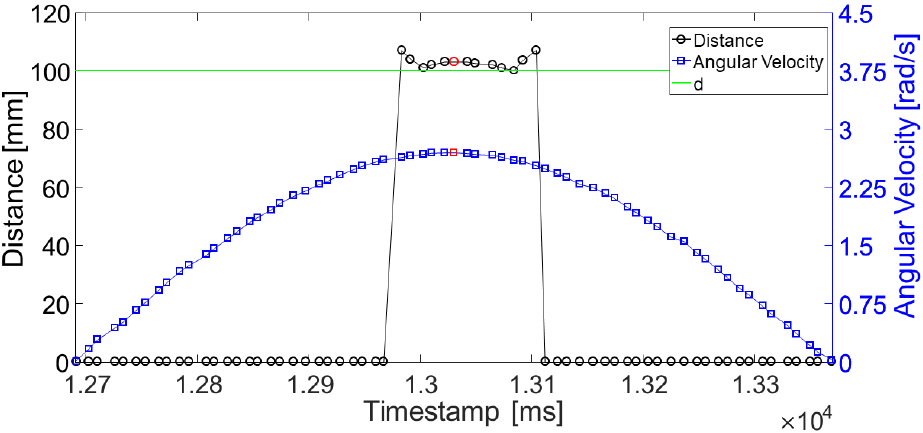
Figure 8. An example of the readings, provided by the Infrared Time-of-Flight proximity sensor (IR-ToF) and re-sampled at 100 Hz, is reported for an oscillation k with an AoI equal to 0 ◦ and d = 100 mm. The value of d IR − ToF , obtained in correspondence of the angular velocity peak (red square), is reported k with a red